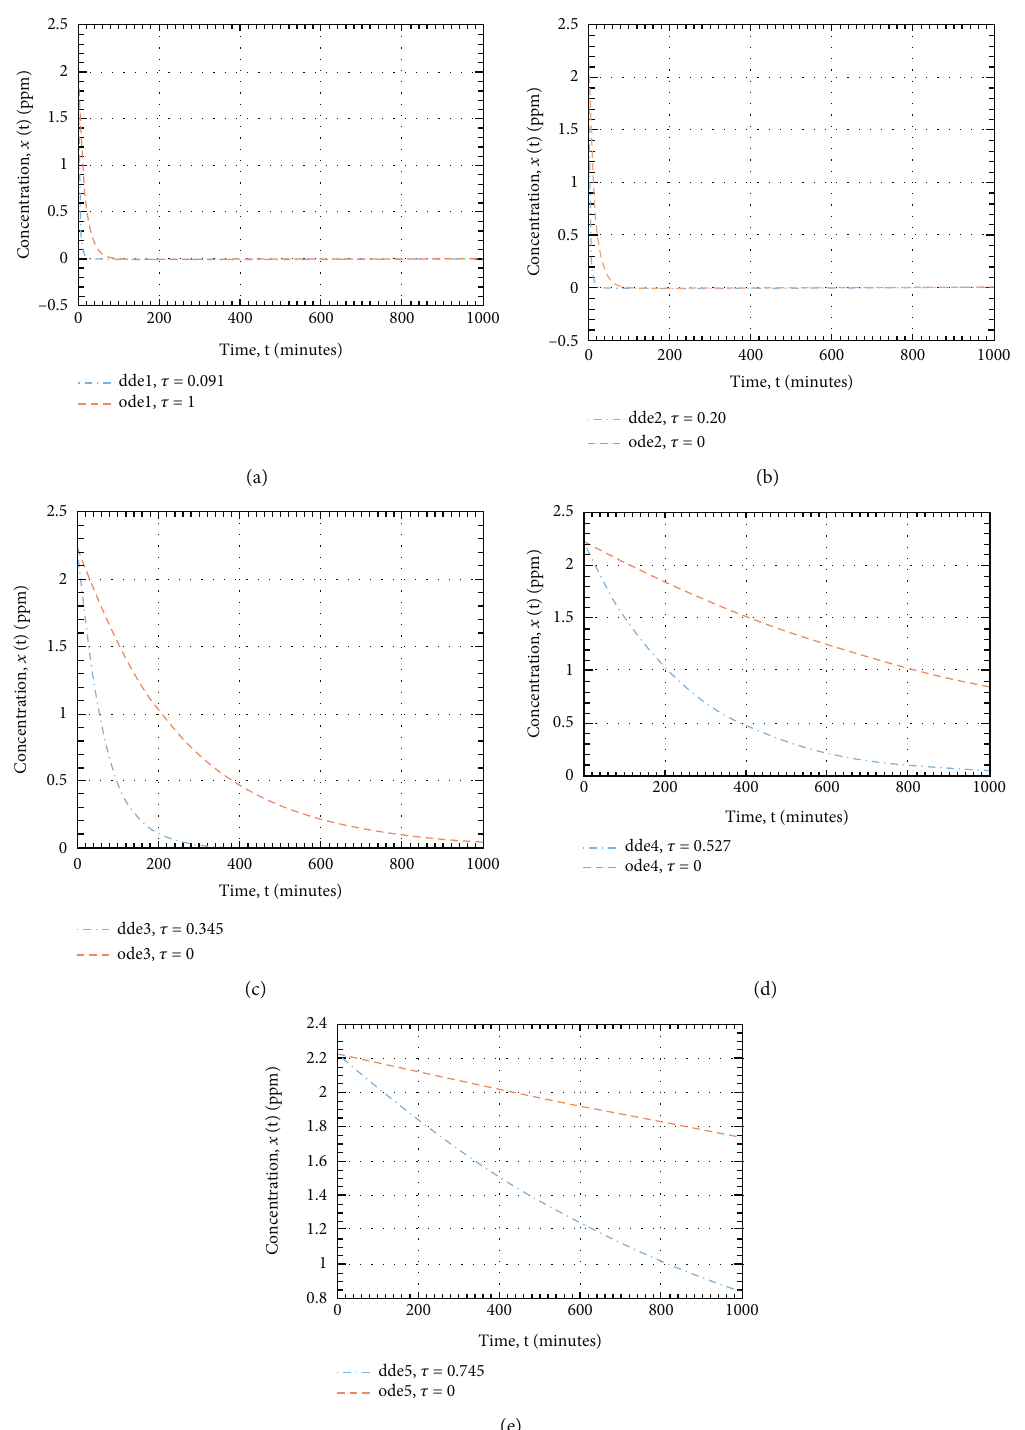
Figure 4: Plots of concentration x ð t Þ versus time t for comparison DDEs and ODEs in modeling rate of particle fl ow in reservoirs of water fl ow